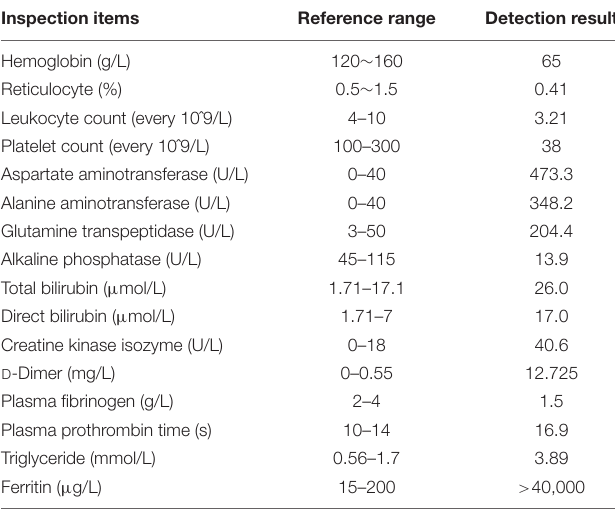
TABLE 1 | Summary of the patients’ laboratory test